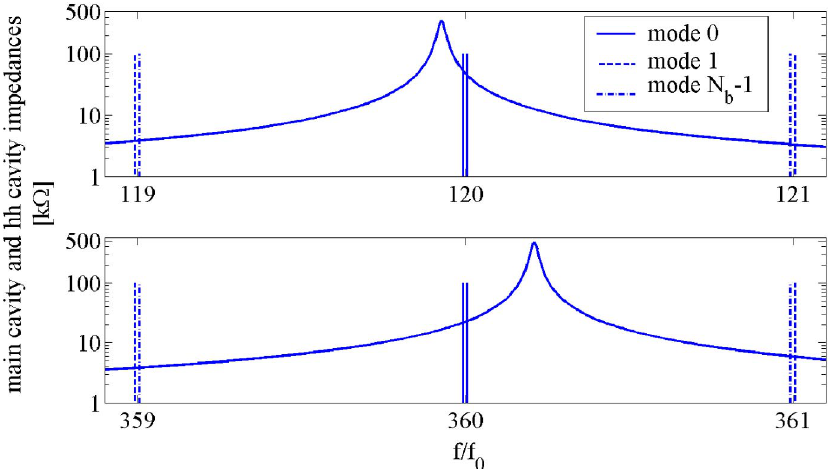
FIG. 3. (Color) Cavity impedances and CB mode